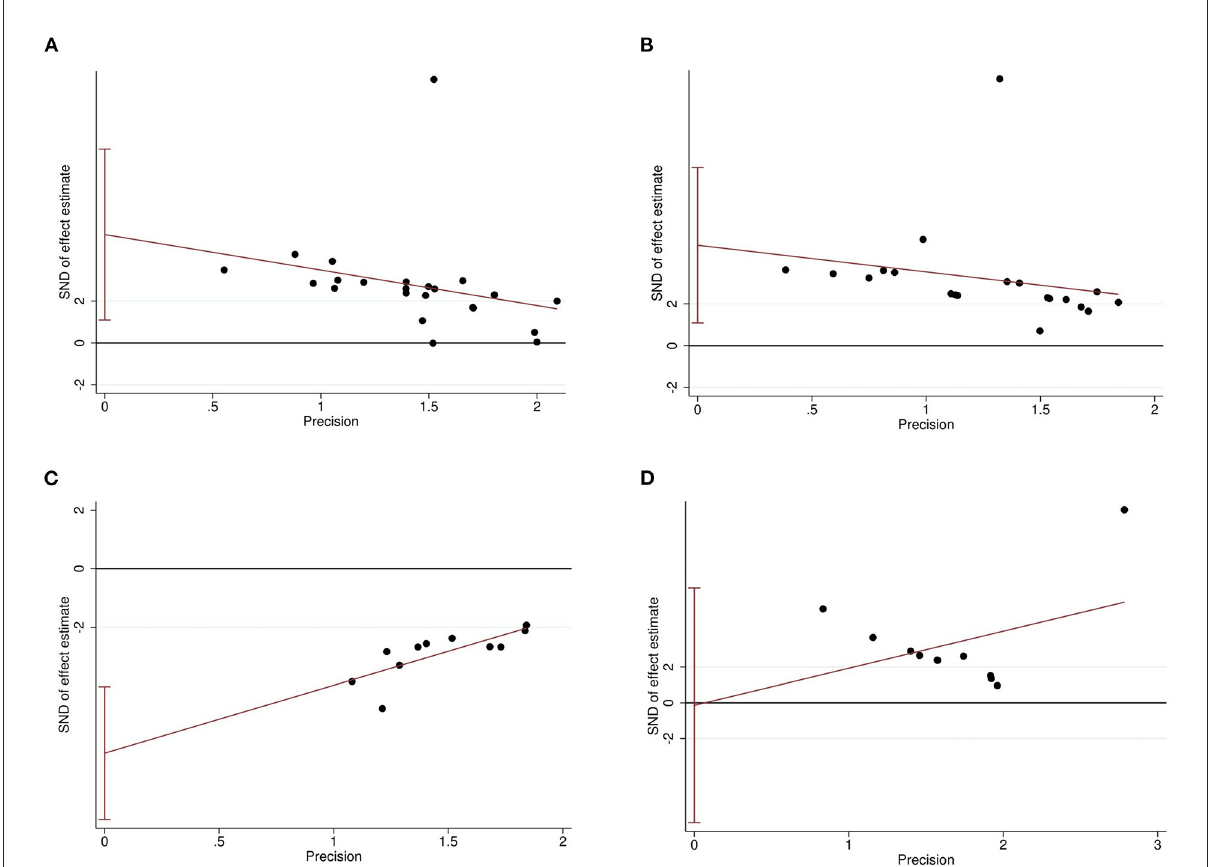
FIGURE10 Egger’s regression for sucrose preference test (A) , open-field test (B) , forced swimming test (C) , and body weight (D) confirming potential evidence for publication bias. The vertical lines represent the 95% confidence